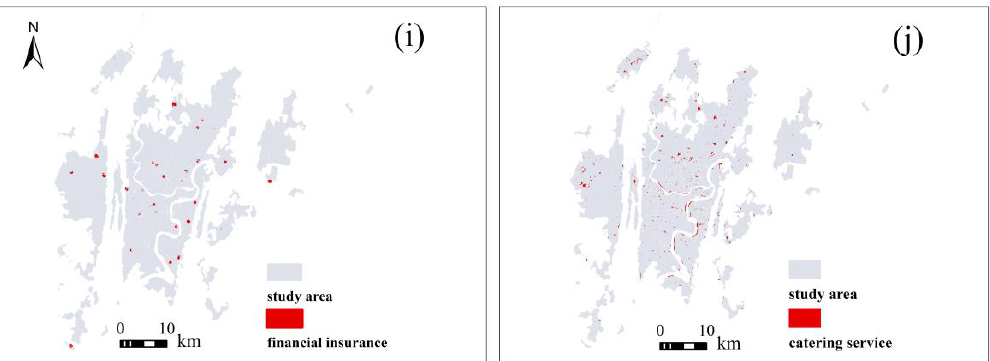
Figure 5. Distribution diagram of the functional mixing degree. ( a ) administration and public service, ( b ) green spaces and squares, ( c ) transportation service, ( d ) medical care, ( e ) education, ( f ) industrial, ( g ) residential service, ( h ) life service, ( i ) financial insurance, ( j ) catering service.